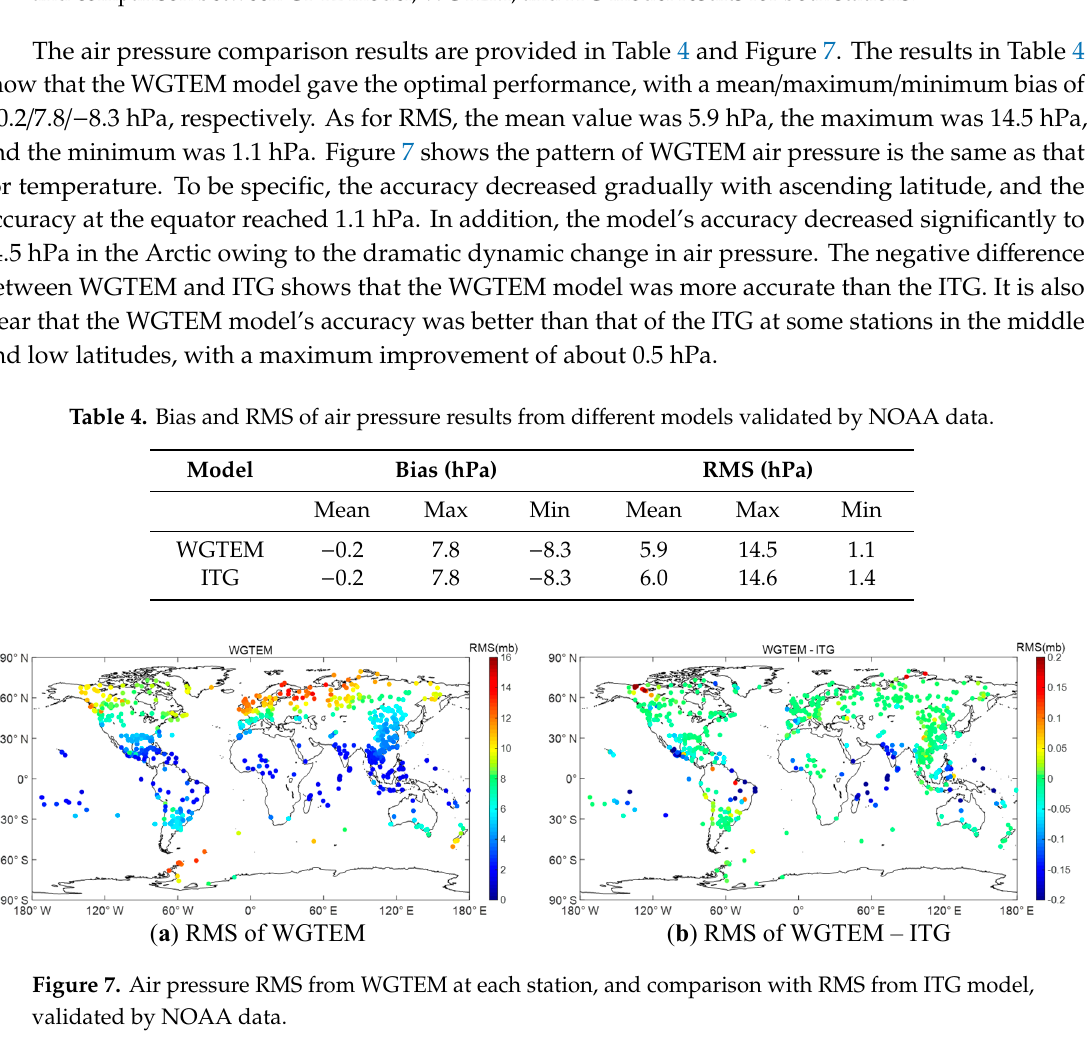
Figure 6. Air pressure time series changes at Chuukeci and Cotobato Stations in 2012 from NOAA, and comparison between GPT2 model, WGTEM, and ITG model results for both stations.